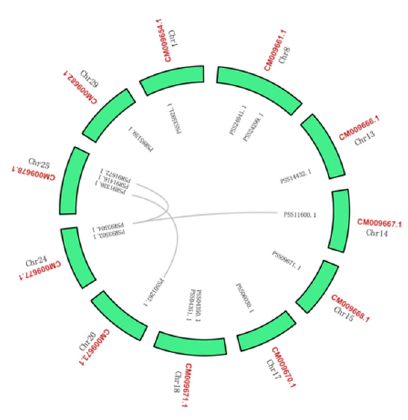
Figure 5. Duplication of the BAM genes in the A. chinensis genome. The synteny relationship between each pair of BAM genes was detected using linear regression. Genes with a asyntenic relationship are linked by grey lines.